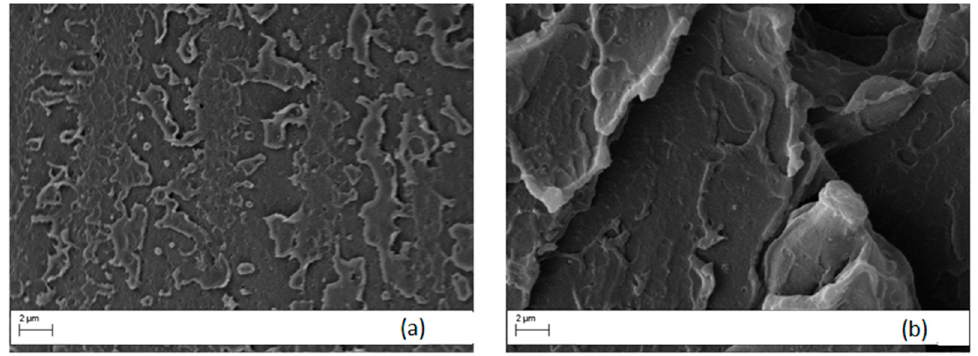
Figure 13. Micrographs of crio-fractured PEI/PETG blends for different PETG content (magnification 10,000×): ( a ) 5 wt %; ( b ) 10 wt %.